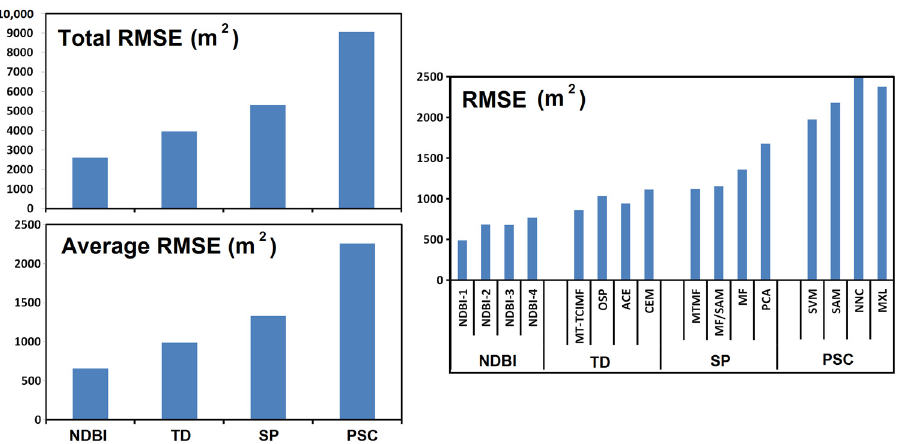
Figure 5. The variation of RMSE among the 16 FE methods utilized for effective blue ice mapping application. RMSE results of the 16 methods were grouped to depict the total RMSE and average RMSE values among the four semi-automatic blue ice feature extraction approaches.